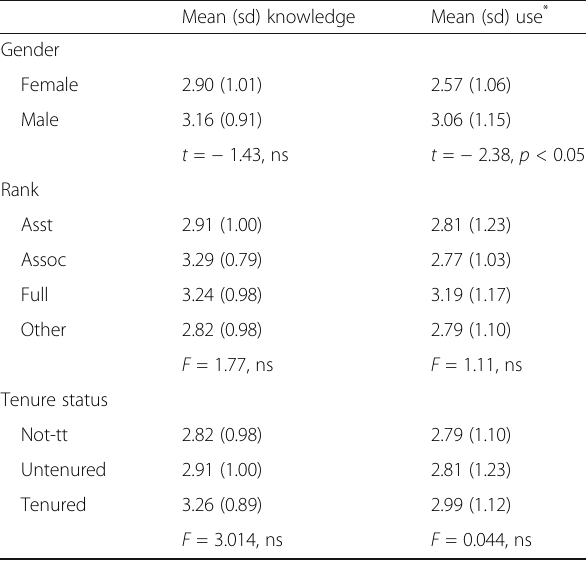
Table 6 EBIP scores and individual